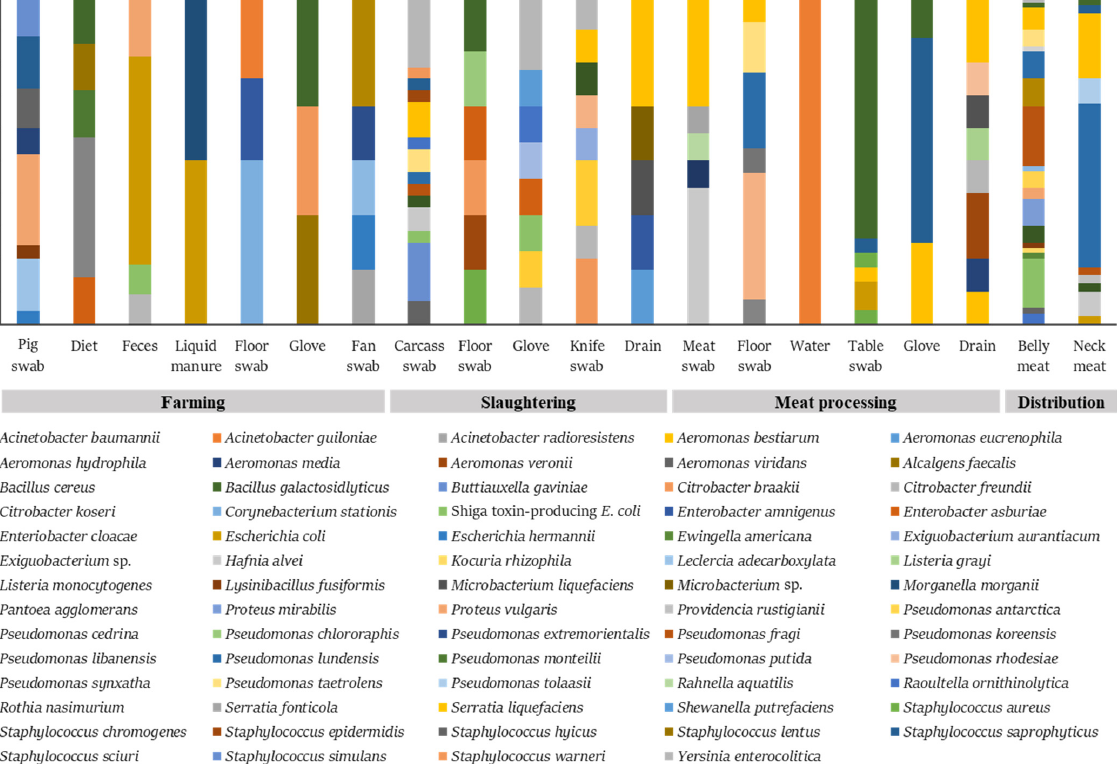
Figure 1. The ratio of pathogens isolated from the pork meat and its producing environment.